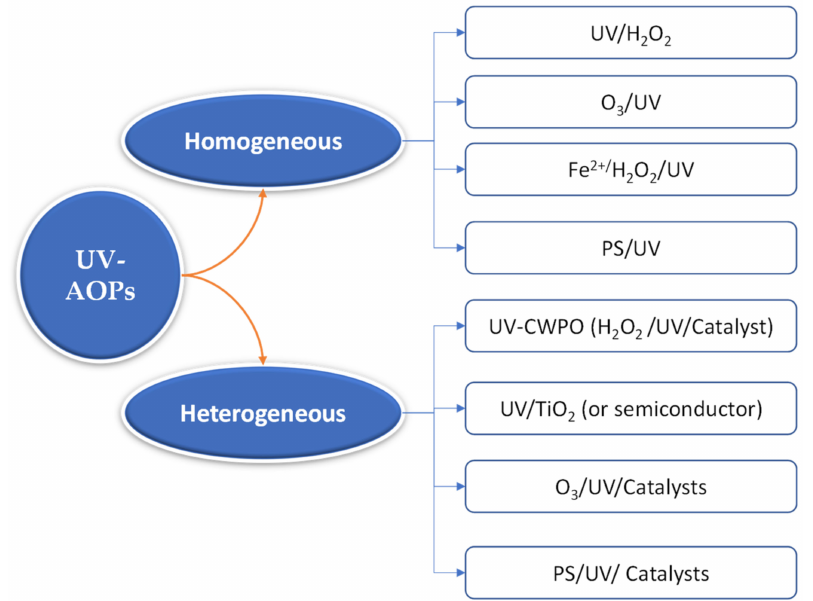
Figure 1. UV-AOPs